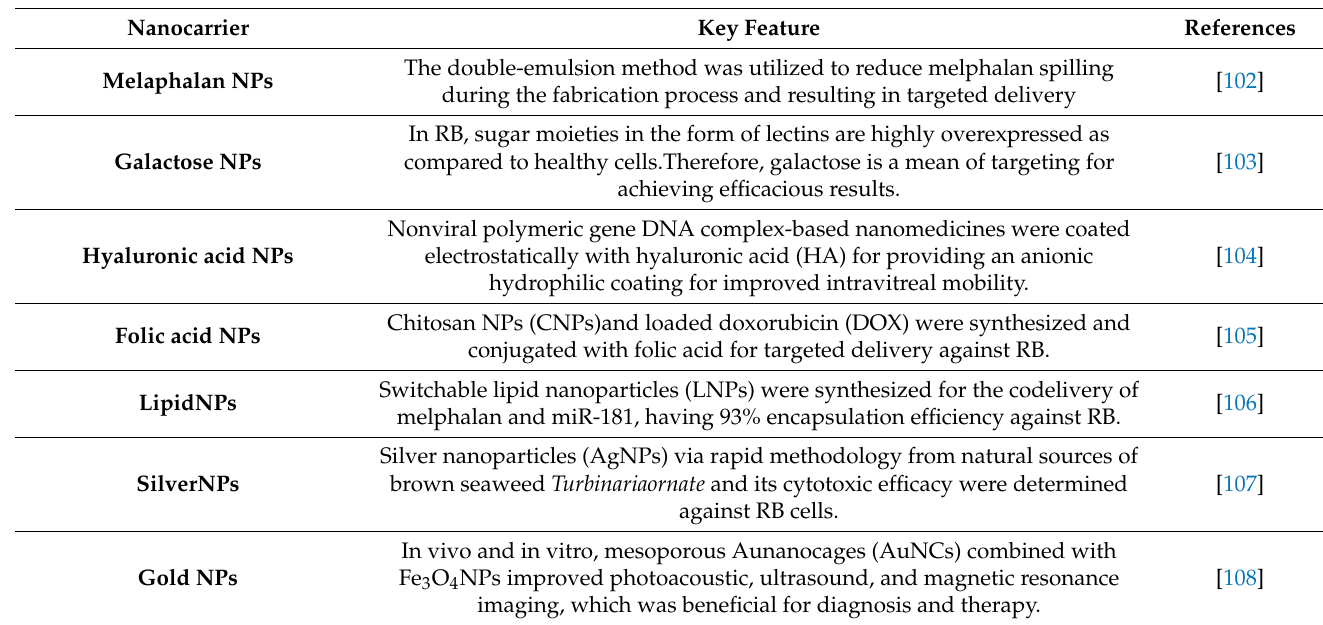
Figure 1. Multi-functionalized nanomaterials for ocular drug delivery to overcome the ophthalmic barriers and treat retinoblastoma. Table 2. Summary of several nanocarriers in the treatment of RB.